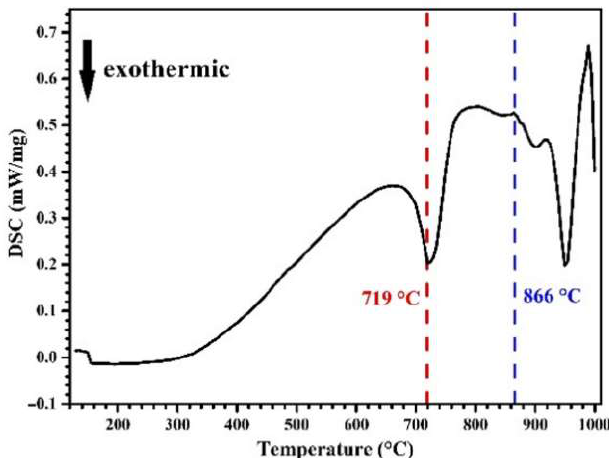
Figure 1. DSC test results of X80 pipeline steel.